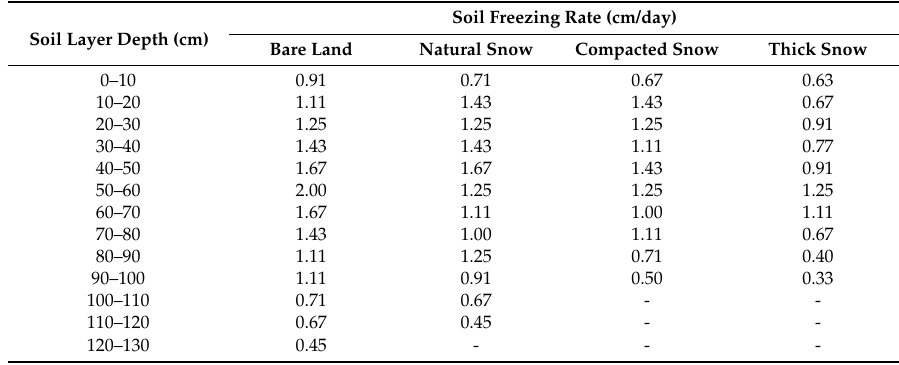
Table 3. The soil freezing